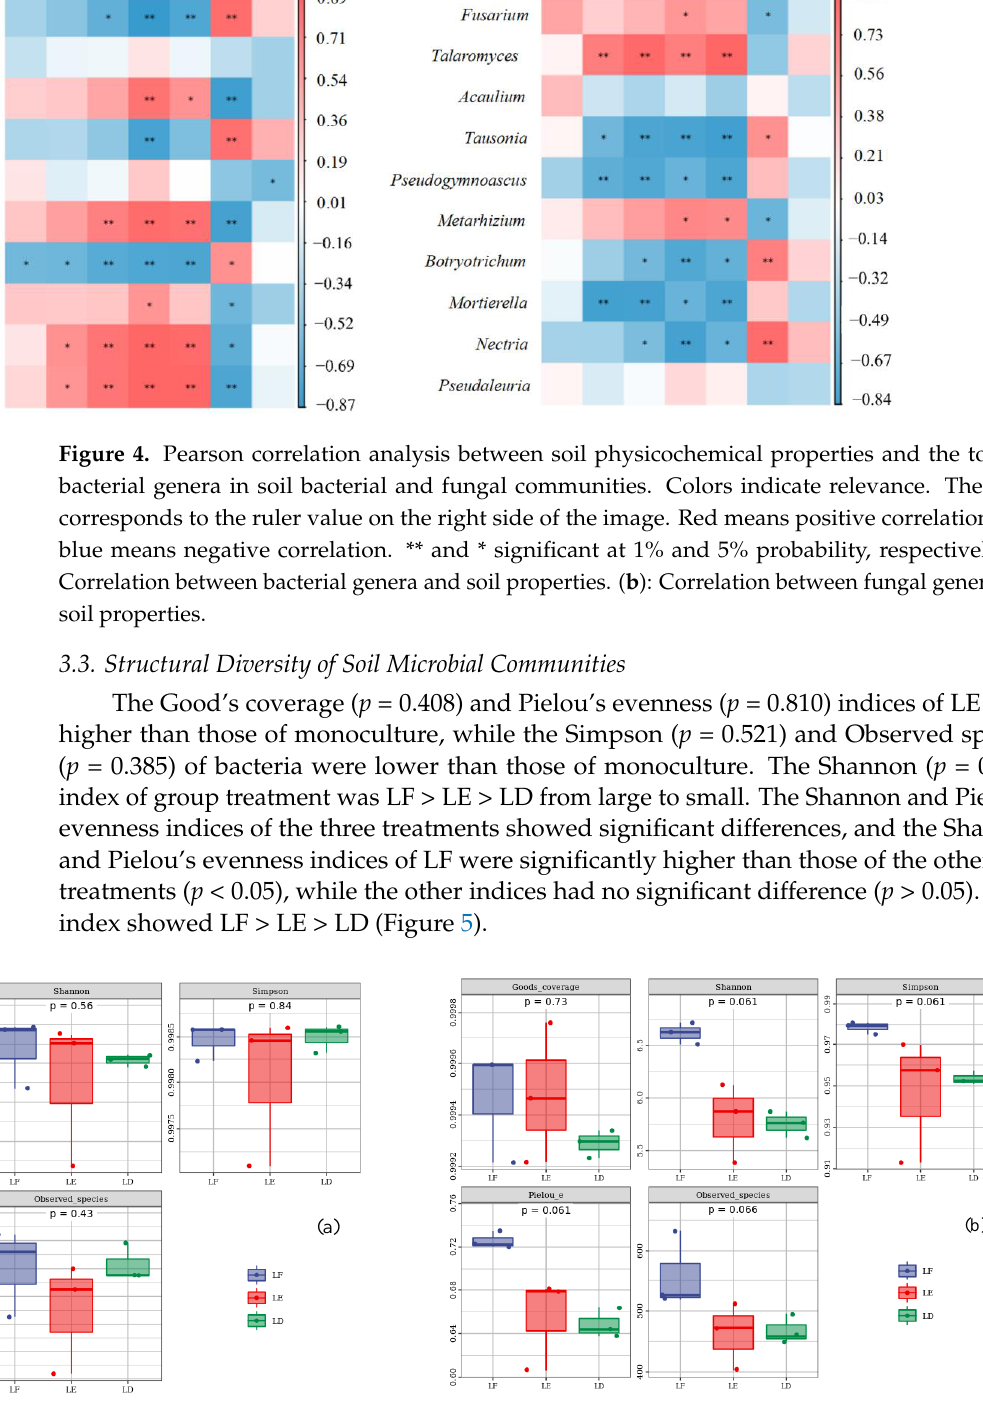
Figure 5. Alpha diversity of bacteria and fungi in rhizosphere soil. The upper and lower end lines of the box indicate the upper and lower quartiles (IQR); the median line indicates the median; the upper and lower edges indicate the maximum and minimum values (extreme values within 1.5-fold of the IQR range). The numbers under the diversity index labels are the p values of the Kruskal–Wallis test. ( a ): Analysis of α diversity of the soil bacterial community. ( b ): Analysis of α diversity of the soil fungal community. The relative abundance of bacteria and fungi at phylum in rhizosphere soil. LF: Morus alba ; LD: Arachis hypogaea ; LE: Morus alba - Arachis hypogaea.